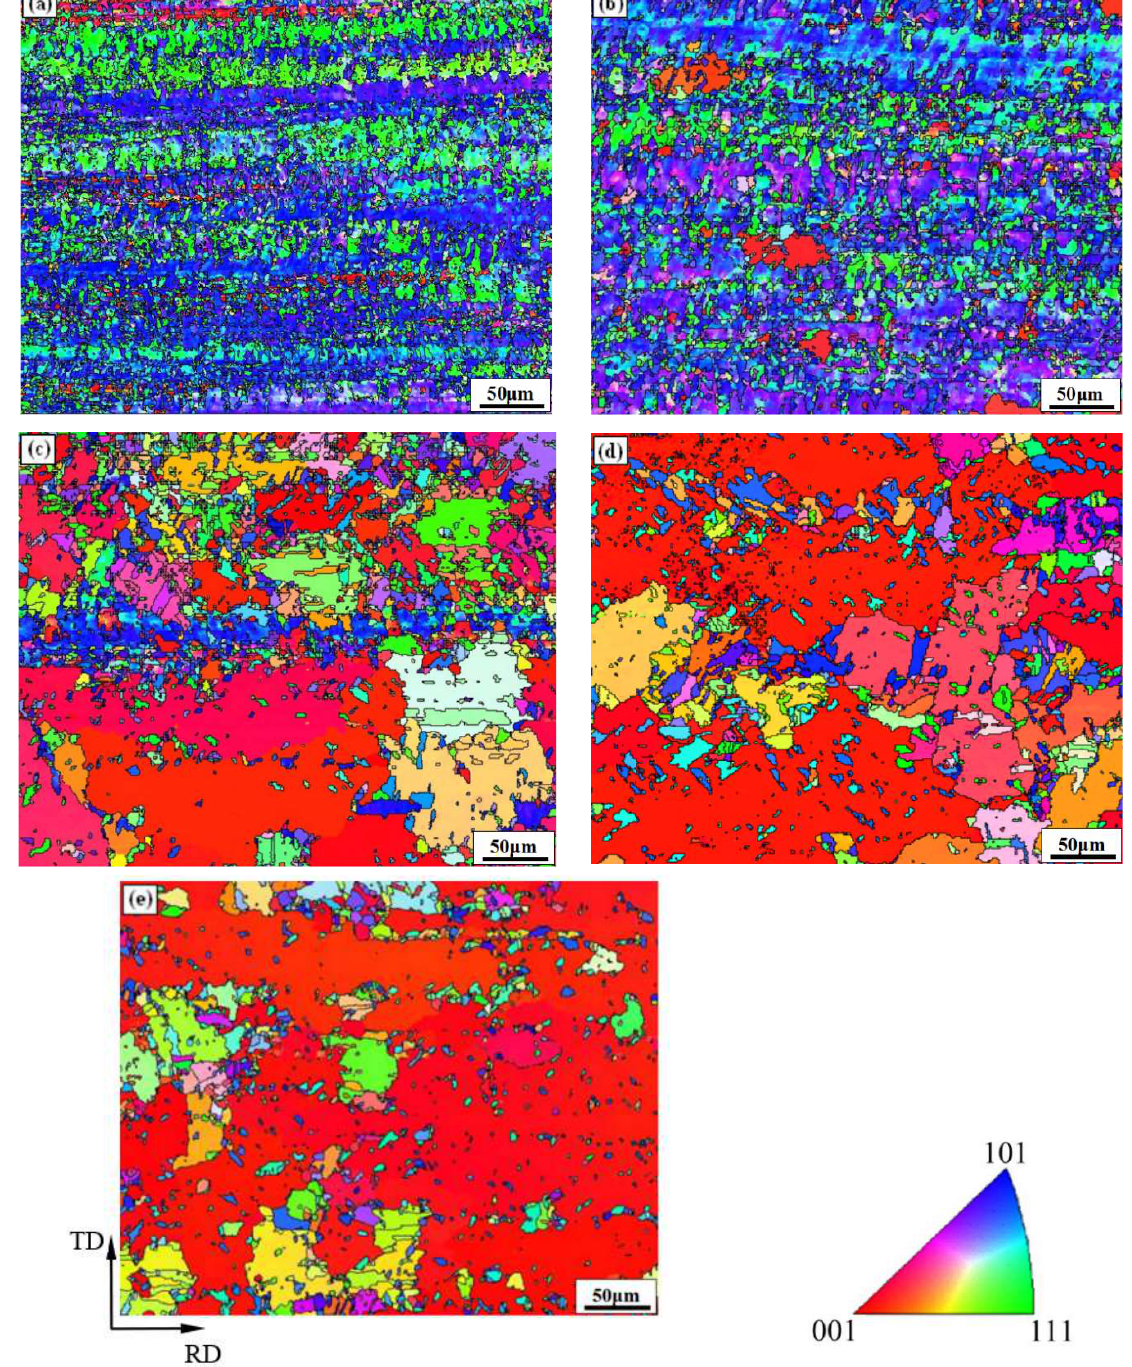
Figure 3. IPF diagram of the rolled and annealed copper foil. ( a ) Rolled sample; ( b ) 1 min; ( c ) 5 min;